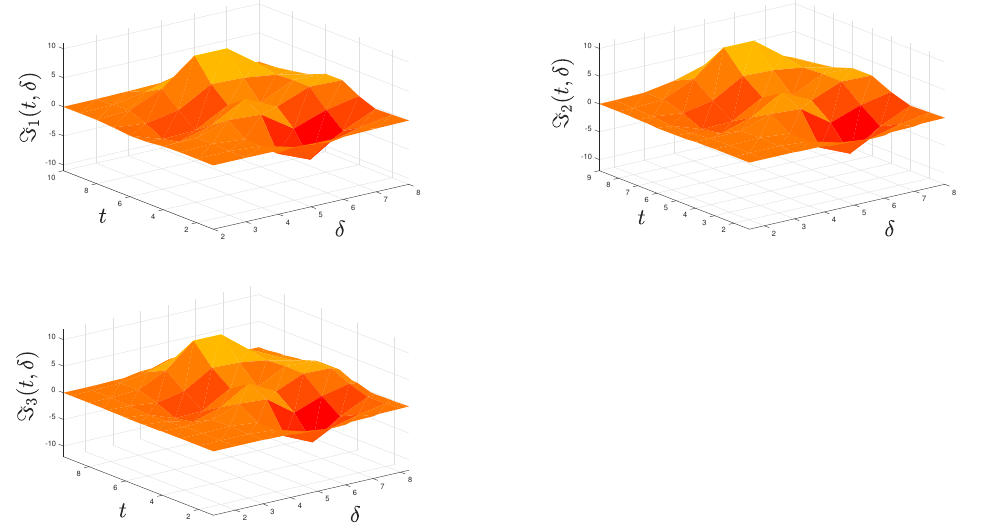
Figure 4. The state trajectories of the corresponding error system of the type (8) in Example 2 with controller (7) for τ =